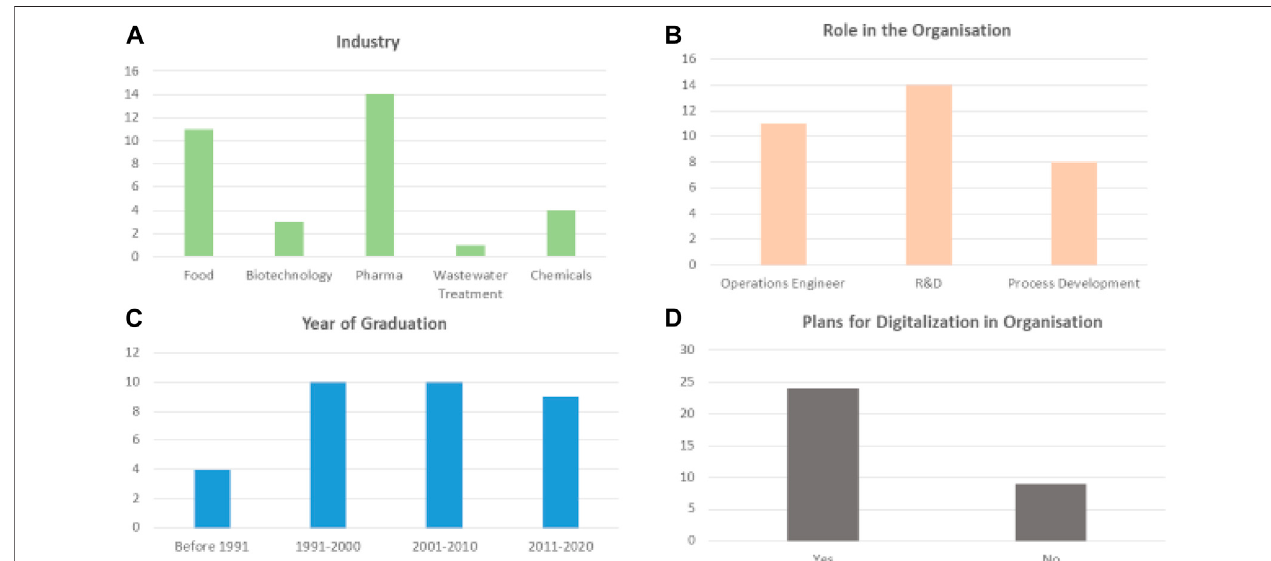
FIGURE3| Demographicsoftherespondents; (A) illustratestheindustry, (B) illustratesthecurrentrole(intheindustry) (C) illustratestheyearofgraduation(levelof experience) (D) illustrates the plans for digitalization within the organization.